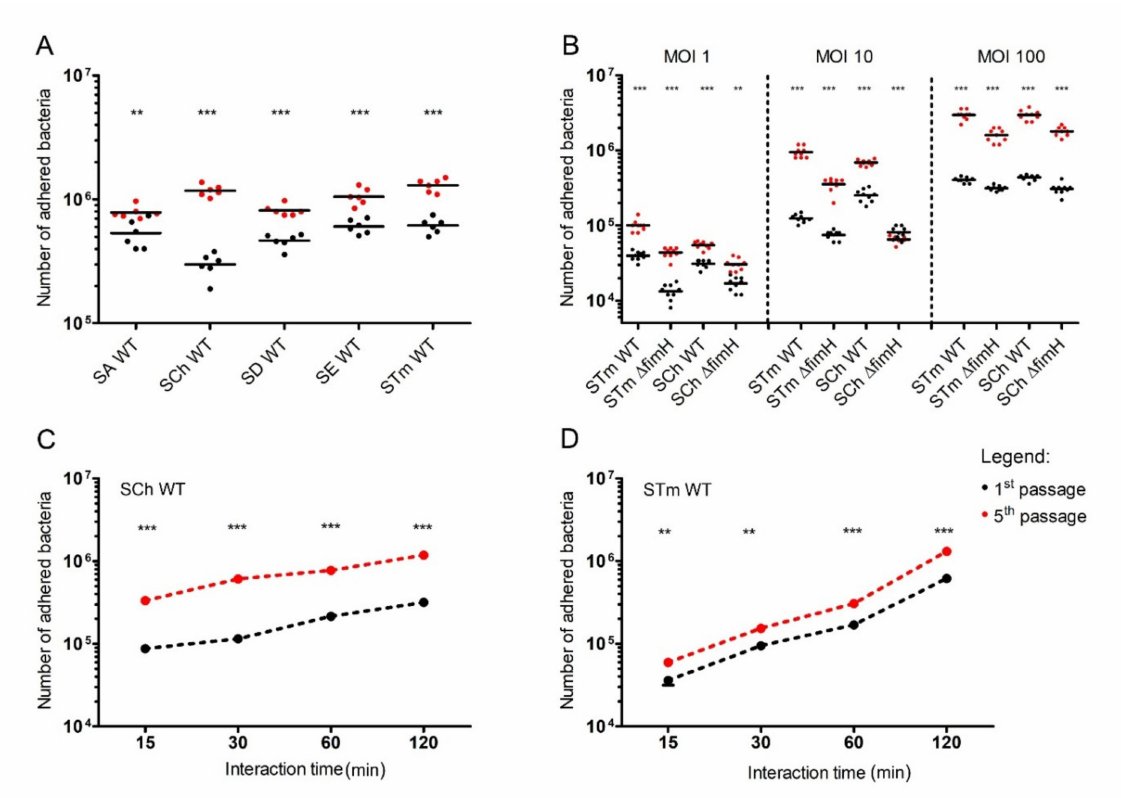
Figure 1. Adherence of Salmonella to porcine intestinal epithelial cell line IPEC-J2. ( A ) Five Salmonella serovars ( S . Abortusovis (SA), S . Choleraesuis (SCh), S . Dublin (SD), S . Enteritidis (SE), and S. Typhimurium (STm)) after the first or fifth passage were incubated (multiplicity of infection (MOI) 50) for two hours with cell monolayers in a 24-well plate. ( B ) S. Choleraesuis (SCh WT) and S. Typhimurium (STm WT) wild types and their ∆ fimH mutants (SCh ∆ fimH and STm ∆ fimH, respectively ) after the first or fifth passage were incubated (MOI 1, 10, and 100) for two hours with IPEC-J2 cell monolayers. ( C ) S. Choleraesuis (SCh) and ( D ) S. Typhimurium (STm) wild types after the first or fifth passage. Statistical di ff erences between the first (black dots) and fifth (red dost) passage were analyzed by Student’s t -test and are presented as individual values with a geometric mean ( A , B ) or as geometric mean ( C , D ). ** p < 0.01, and *** p <